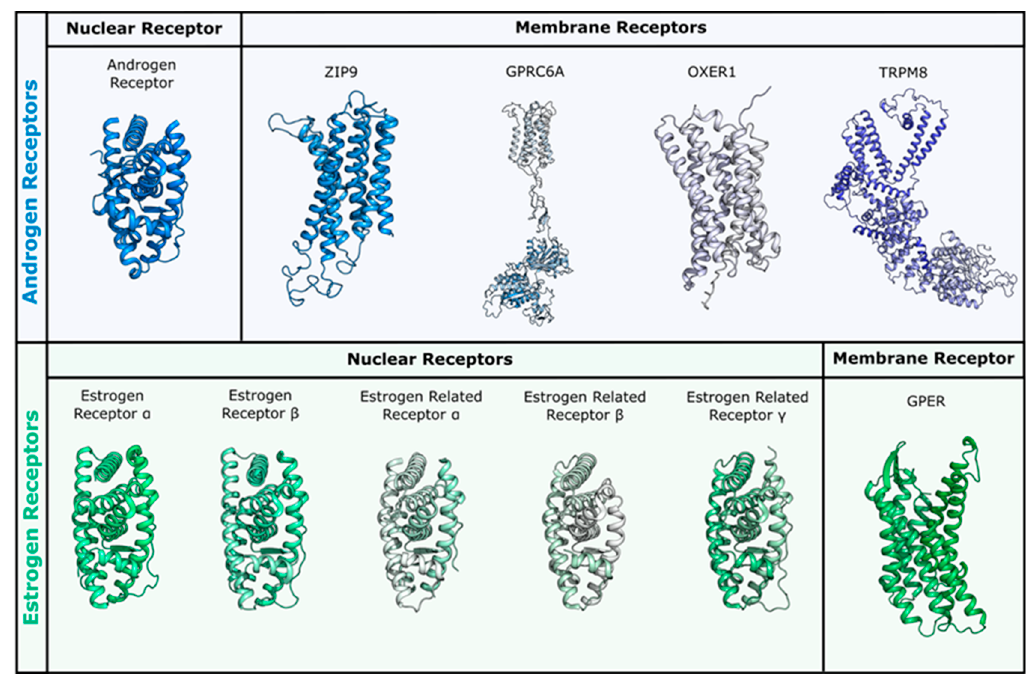
Figure 1. Flavonoids and sex steroid hormones docked in nuclear and membrane receptors shown in Figure 2. Compounds are indicated by their acronyms, as in the introduction and in the following legend: apigenin (API), genistein (GEN), luteolin (LUT), naringenin (NRG), quercetin, (QRC), resveratrol (RESV), 17 β -estradiol (E2), dihydrotestosterone (DHT), and testosterone (T).